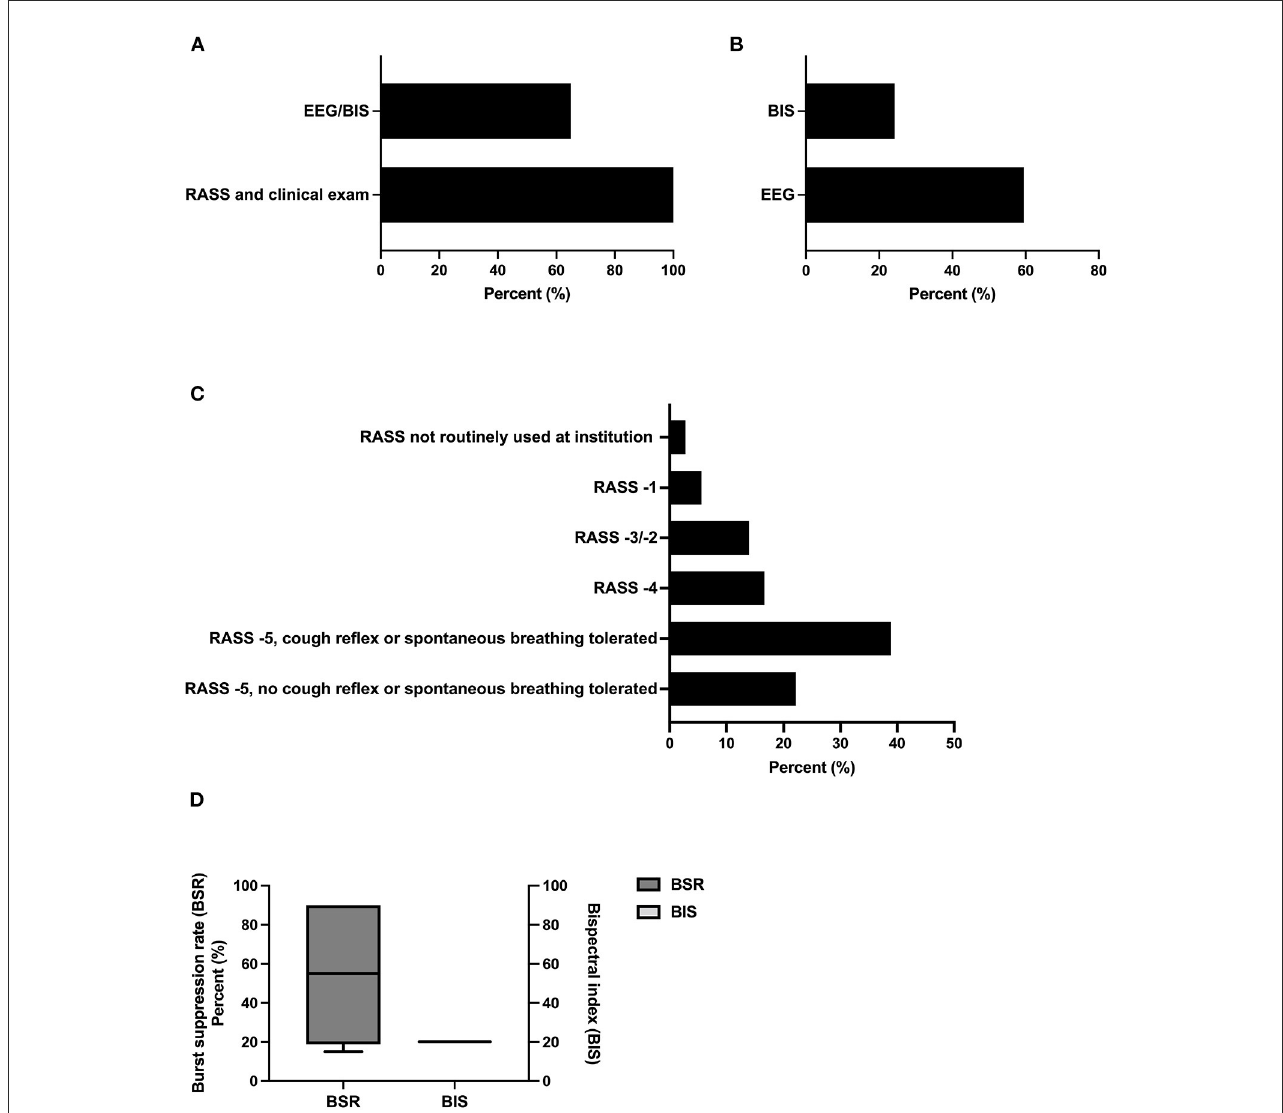
FIGURE3 Methods and thresholds for monitoring the level of sedation. (A) Methods used for monitoring the level of sedation ( n = 37, multiple selections). (B) Methods used for monitoring via EEG-based techniques ( n = 31, multiple selections). (C) Therapeutic targets using RASS as monitoring of the level of sedation (n = 37). (D) Therapeutic targets using BIS/EEG as monitoring of the level of sedation (BSR n = 6; BIS n = 2). BSR was defined as the total time of suppression/epoch length × 100%. BIS, bispectral index, EEG, electroencephalography, BSR, burst suppression